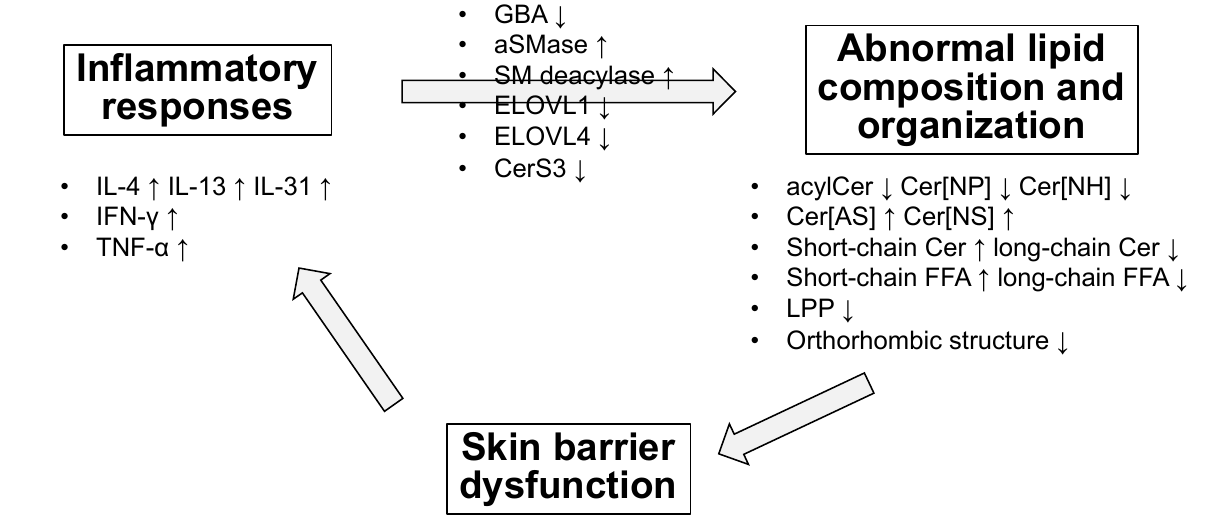
Figure 5. Lipid abnormalities in atopic dermatitis (AD) and their possible underlying mechanisms. In patients with AD, the composition and organization of lipids, especially ceramides, are altered; thus, the expression and activities of the enzymes associated with ceramide synthesis or degradation are involved. The mechanism has not been fully elucidated, but the involvement of Th2 and Th1 cytokines and that of TNF- α are implicated.